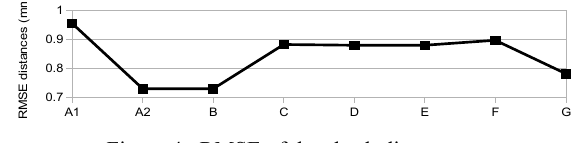
Figure 4. RMSE of the check distances.